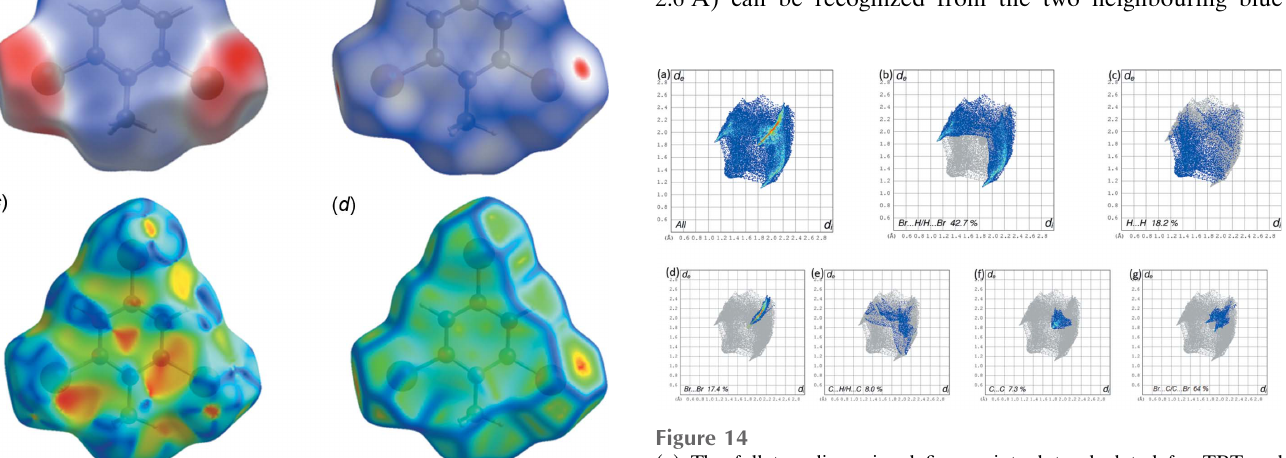
Figure 12 Hirshfeld surface for TBT mapped over ( a ) calculated electrostatic potential, ( b ) d norm , ( c ) shape-index and ( d ) curvedness.